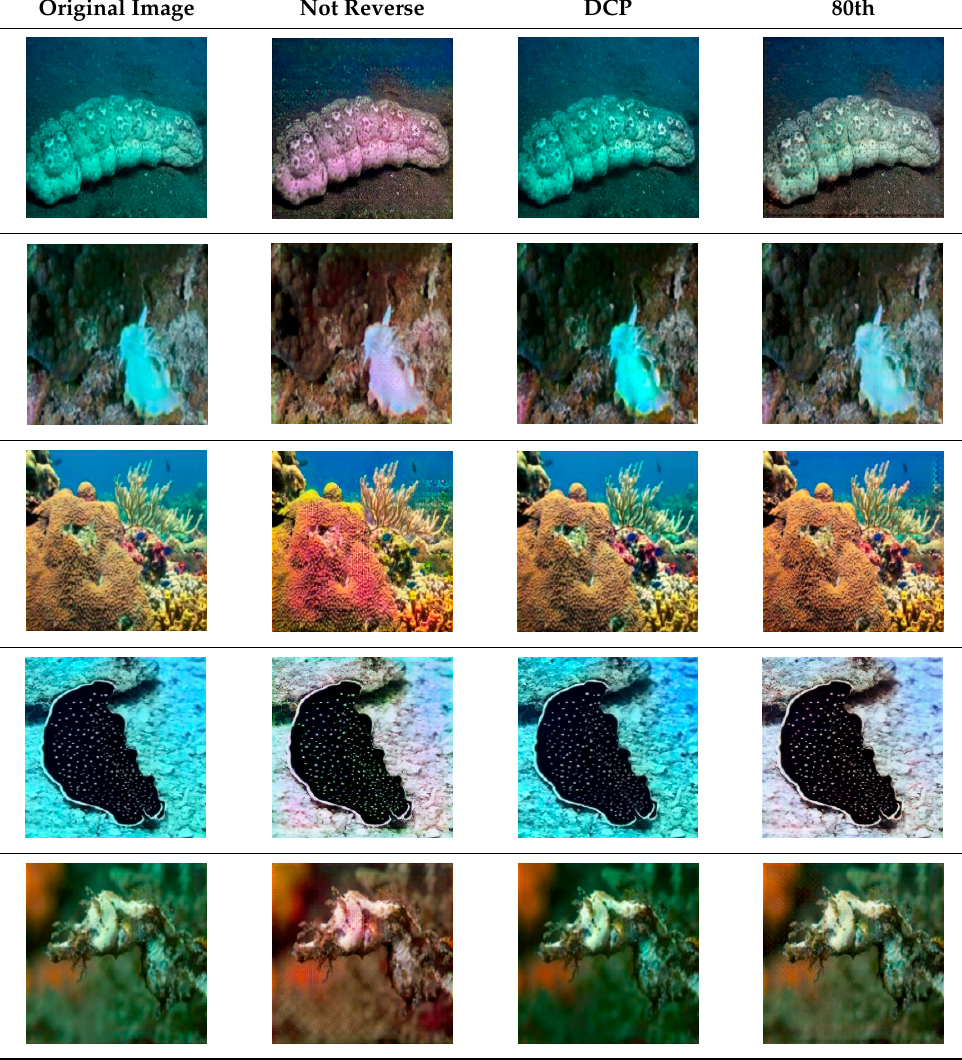
Table 6. Qualitative comparison of the underwater images. Original Image